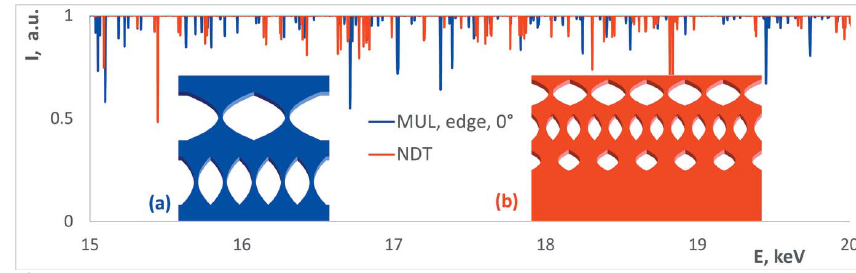
Figure 2 Normalized spectra of glitches for the two CRLs: blue ( a ) MUL and red ( b ) NDT. More details regarding the lenses can be found in the work of Polikarpov et al. (2018), Zhang et al. (2019).